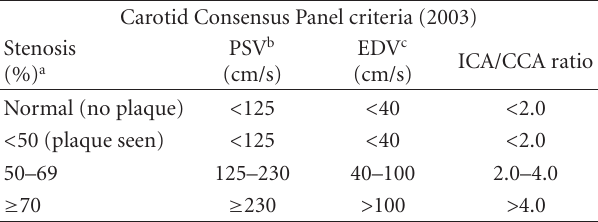
Table 2: Carotid Consensus Panel criteria